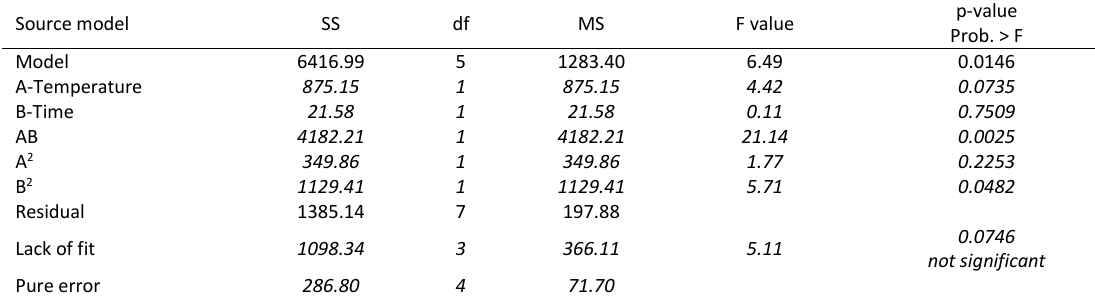
Table 3c: Analysis of variance (ANOVA) for Colour removal Source model